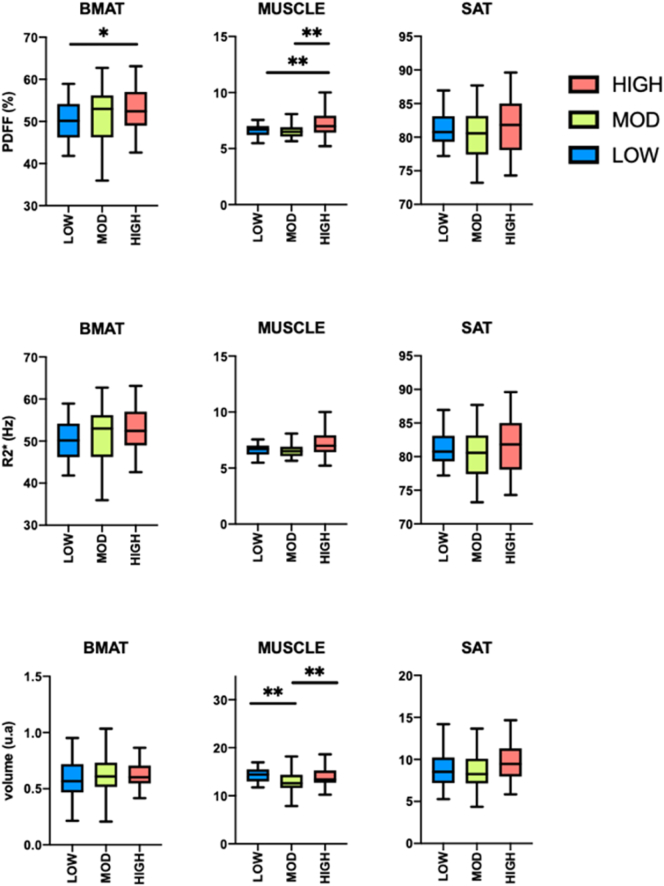
Box and whisker plots of PDFF, R2* and volume in proximal femoral bone marrow adipose tissue (BMAT), thigh muscle (MUSCLE), and subcutaneous adipose tissue (SAT). (On each box, the central mark indicates the median, and the bottom and top edges of the box indicate the 25th and 75th percentiles, respectively. Statistical significance threshold *: p < 0.05, **: p < 0.01).